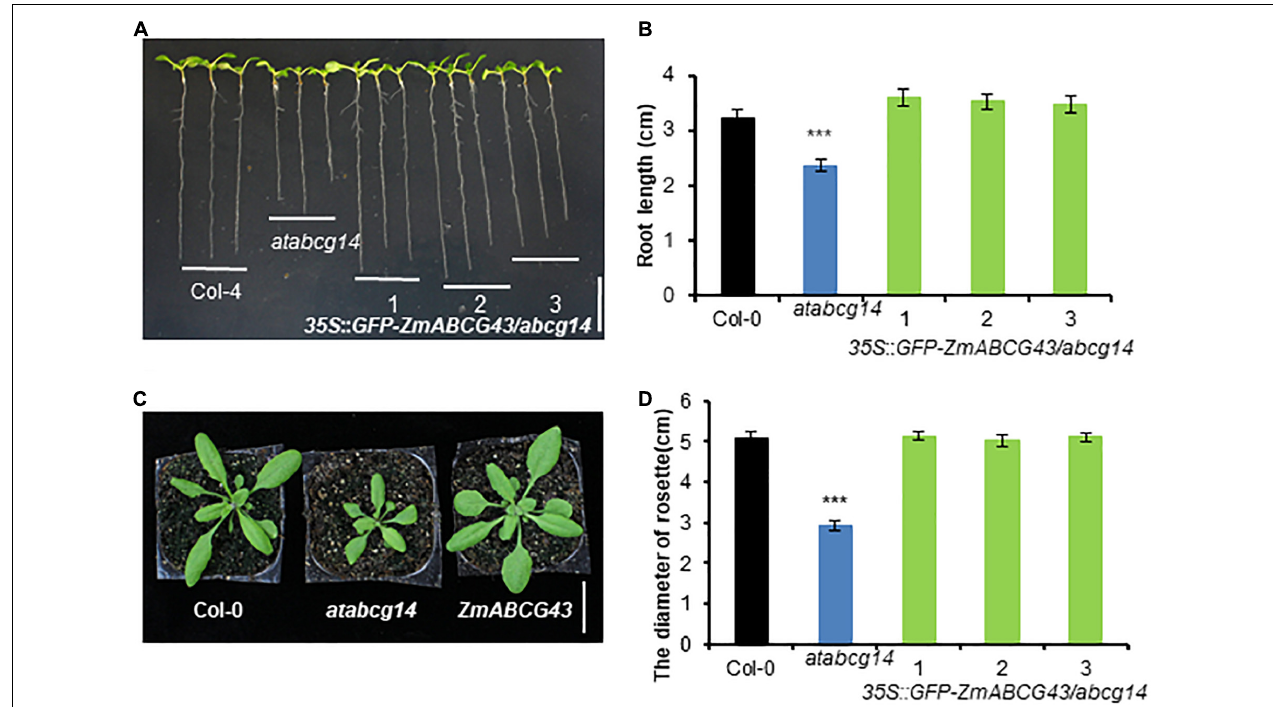
FIGURE 7 | Expression of ZmABCG43 rescued the development phenotypes of atabcg14 mutant. (A) 10-DAG plants of Col-4, atabcg14 mutant, and atabcg14 mutant transformed with ZmABCG43 under the CaMV35S promoter. Scale bar, 1 cm. (B) Root length of the seedlings in (A) . (C) 25-DAG plants of Col-4, atabcg14 mutant, and atabcg14 mutant transformed with ZmABCG43 under the CaMV35S promoter. Scale bar, 2 cm. (D) Diameters of the rosette leaves of the plants in (C) . The data are means ± SD ( n ≥ 7), ***, P < 0.001 (Student’s t